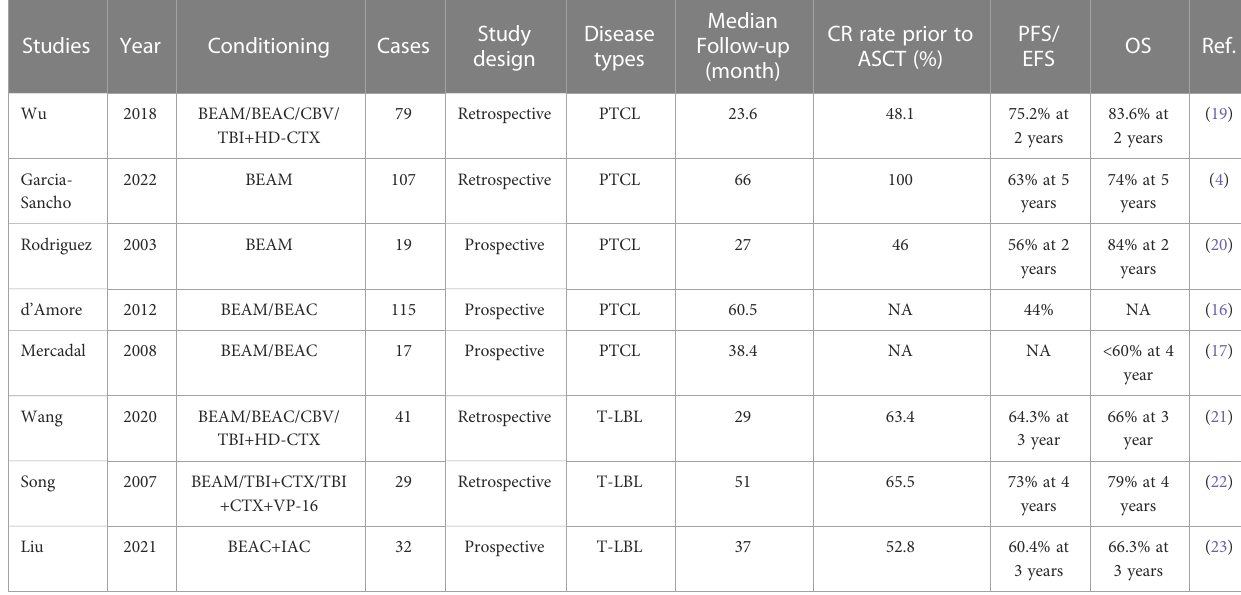
TABLE 4 Review of published studies of ASCT in PTCL and